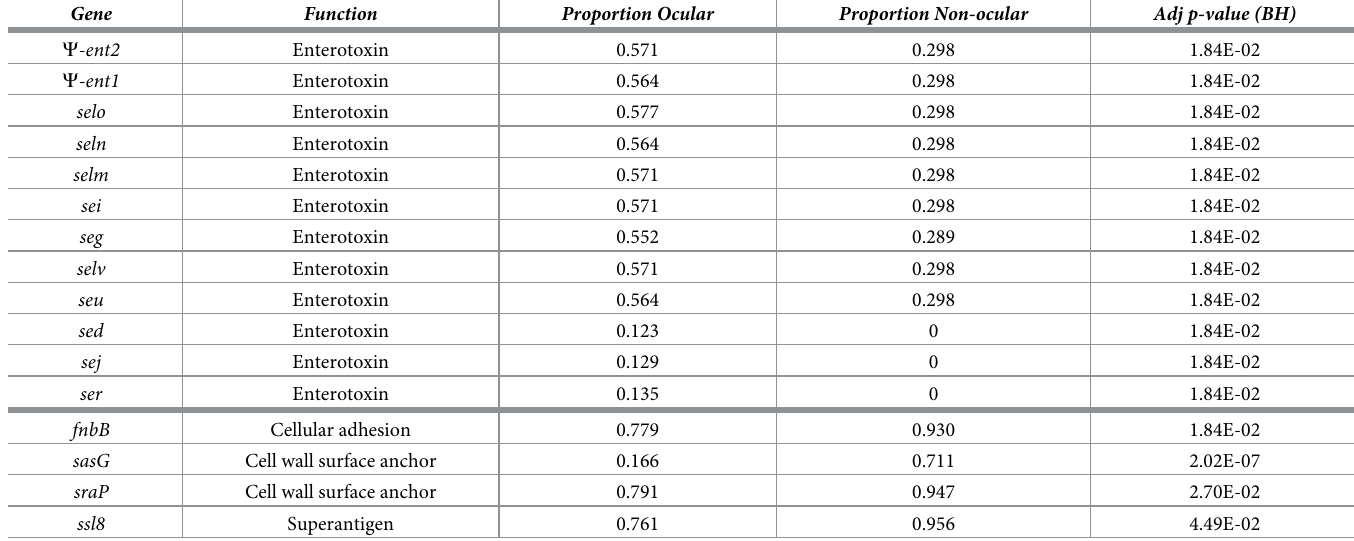
Table 2. Virulence factors enriched among ocular and non-ocular strains, controlling for both MRSA/MSSA status and geography of strain origin.